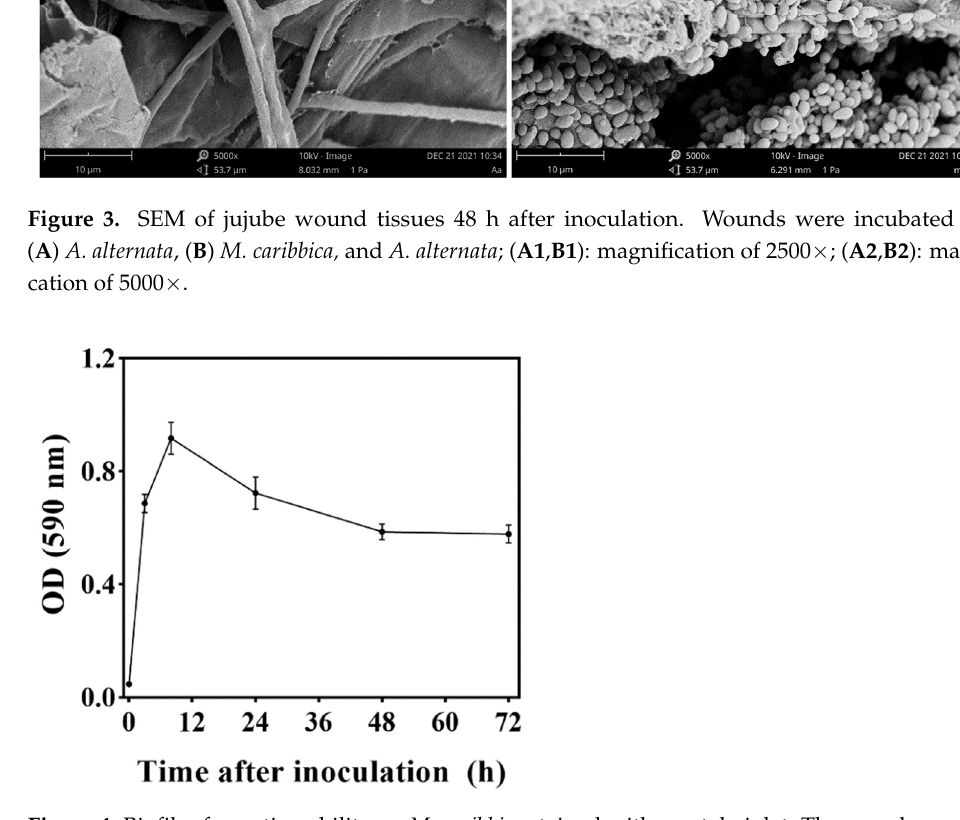
Figure 4. Biofilm formation ability on M. caribbica stained with crystal violet. The error bar reflects the standard deviation of the mean.